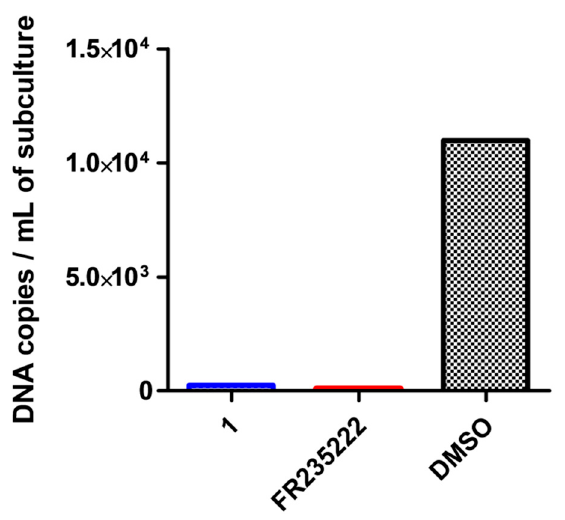
Figure 4. Fluorescent compound 1 is effective on ex vivo T. gondii cysts in in vitro assays. Prior treatment of ex vivo PRU strain cysts with 1 (c = 200 nM) or FR235222 (c = 200